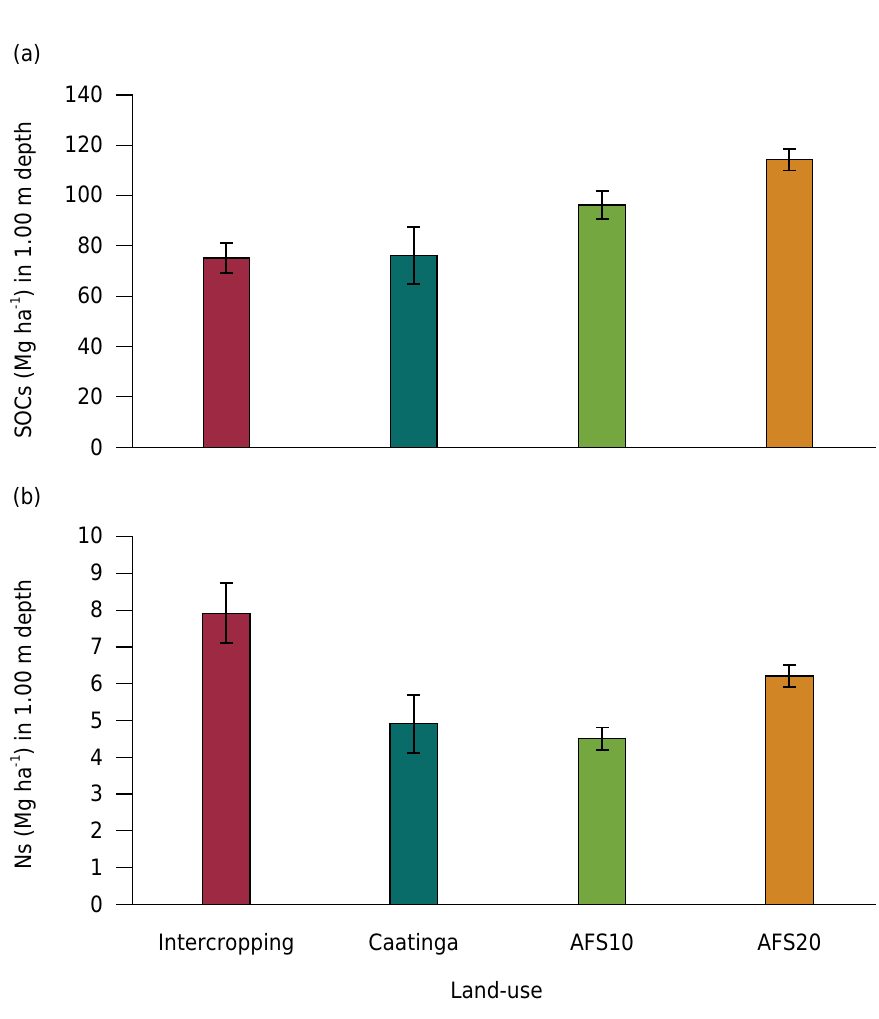
Figure 1. Accumulated soil organic carbon (a) and nitrogen (b) stocks up to 1.00 m of deepth under the influence of intercropping, Caatinga and agroforestry systems (AFS10 and AFS20). Vertical lines on the bars indicate the confidence interval of means (p<0.05). AFS10: Agroforestry with strips of native forest 10 m wide; AFS20: Agroforestry with strips of native forest 20 m